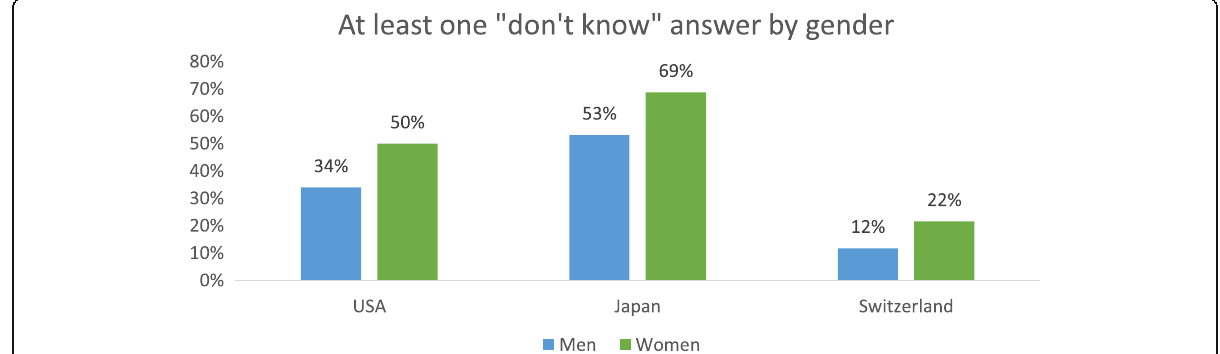
Fig. 2 Gender differences in the responses to the Big Three questions. Sources: USA — Lusardi and Mitchell, 2011c; Japan — Sekita,